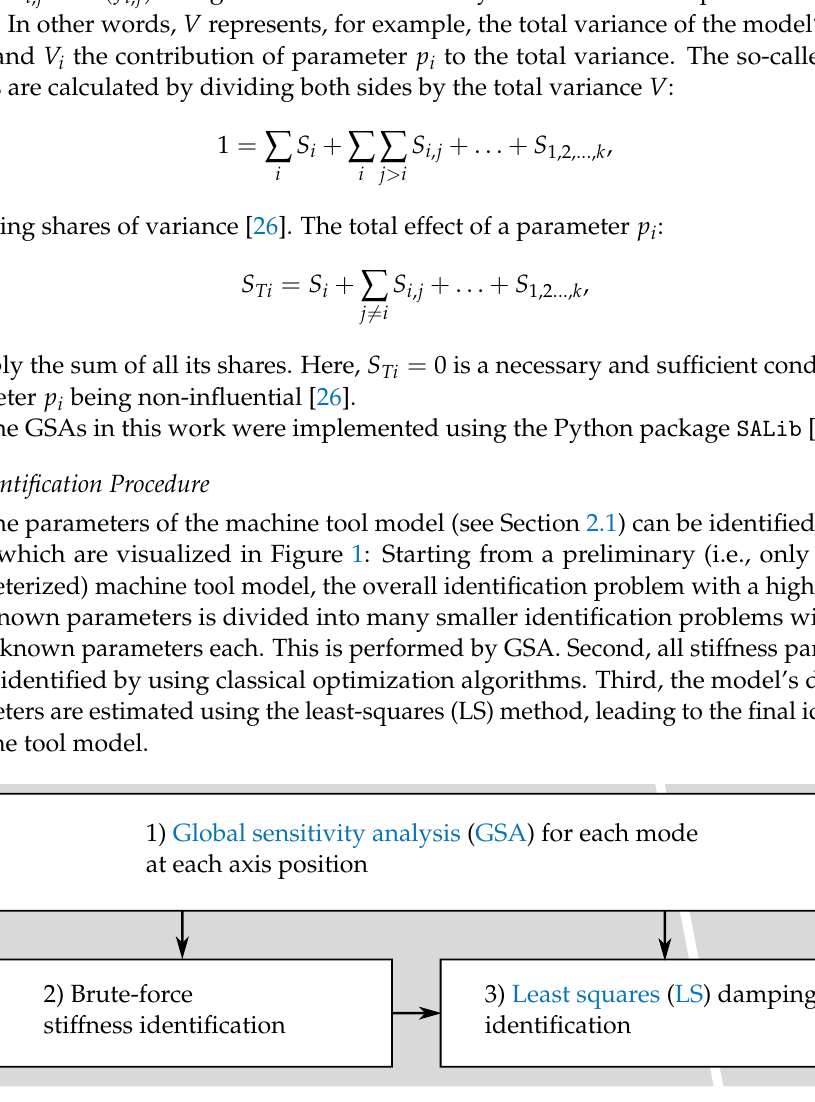
Figure 1. Overview of the proposed identification